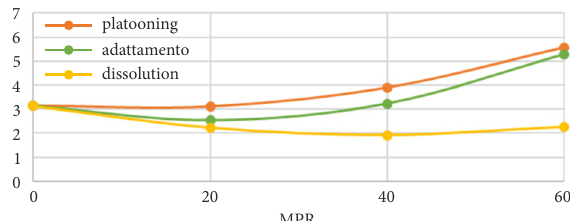
Figure 15. Failed merging attempt [% of vehicles failing to merge over the flow entering through the on-ramp] – driving as usual (orange); headway adaptation (green); dissolution